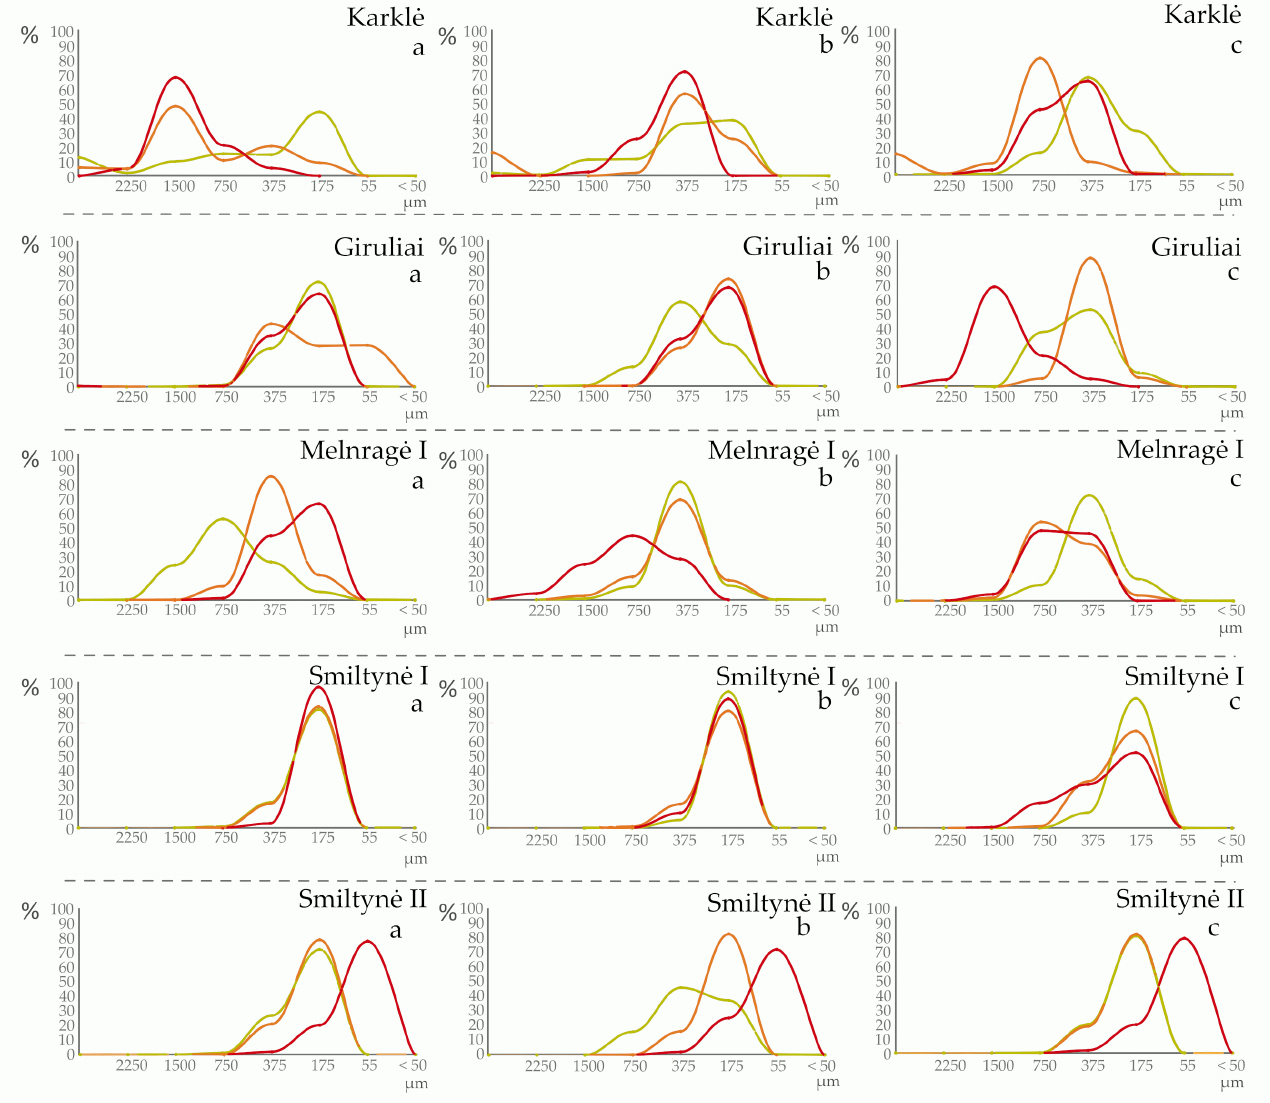
Figure 8. Grain size composition of surface sediments at profiles from Karklė , where a — dynamic shoreline, b — mid-beach, and c — foredune; Giruliai, where a — dynamic shoreline, b — mid-beach, and c — foredune; Melnragė I , where a — dynamic shoreline, b — mid-beach, and c — foredune; Smiltynė I , where a — dynamic shoreline, b — mid-beach, and c — foredune; Smiltynė II , where a — dynamic shoreline, b — mid-beach, and c — foredune, throughout 2003 (red line), 2012 (orange line), and 2022 (yellow line) years.